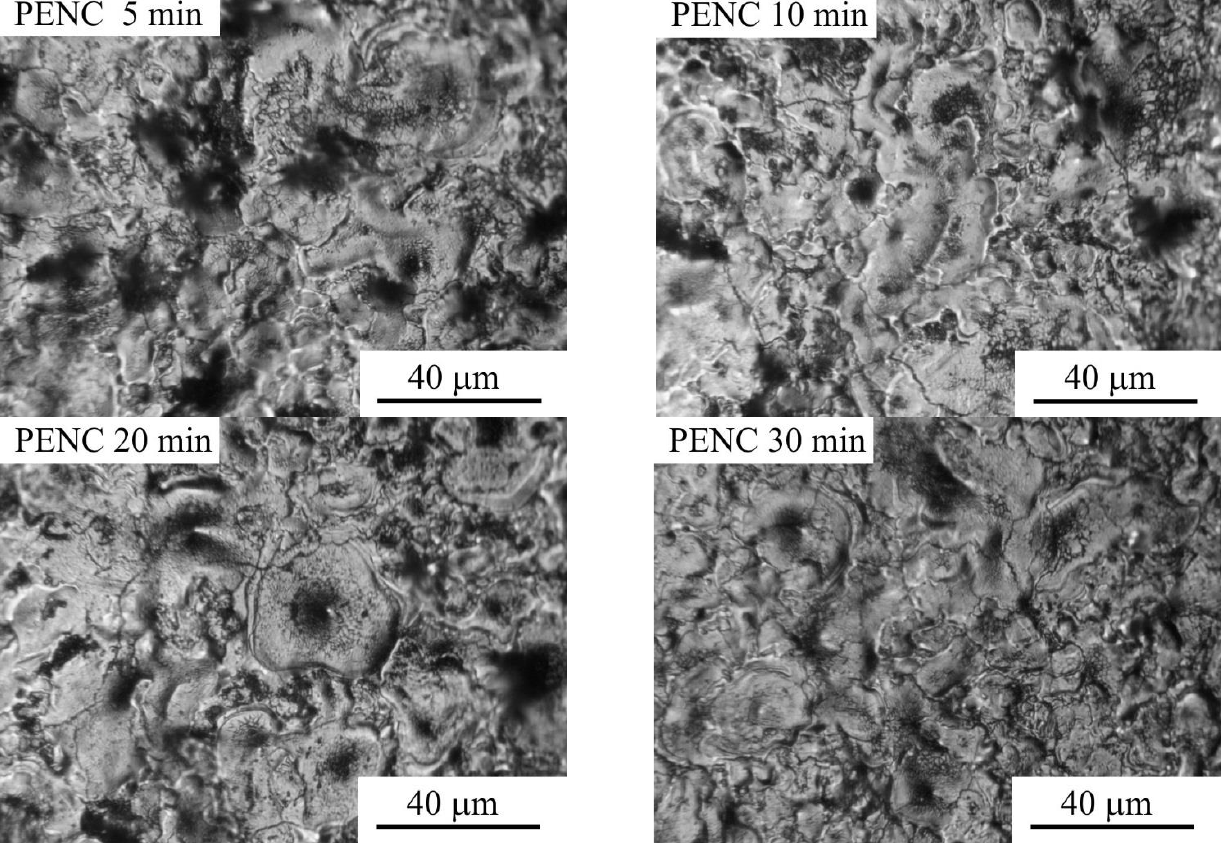
Figure 3. Morphology of the steel surface after cathodic PENC.